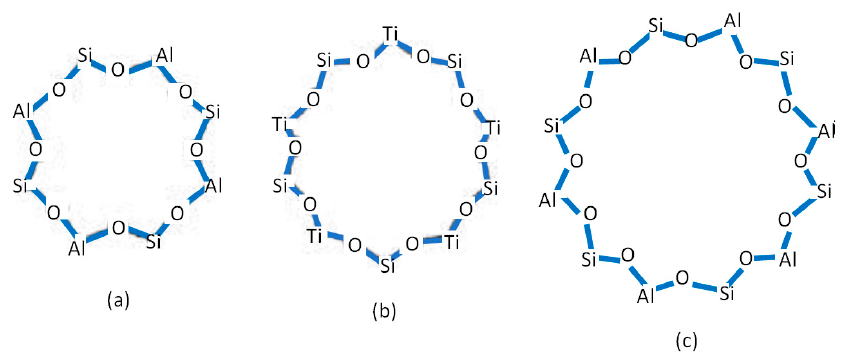
Figure 1. The pore geometry of ( a ) zeolite LTA, ( b ) zeolite TS-1, and ( c ) zeolite Y. Zeolite X has the ability to attract other molecules that touch the surface of the zeolite [21]. Zeolite X has a large Si/Al ratio, so it has thermal and chemical stability [22]. Zeolite X is a type of zeolite that has an α -cage (supercage) diameter of 13 Å, a β -cage (sodalite frame) diameter of 6.6 Å, and a pore diameter of 7.4 Å that form a three-dimensional struc- ture with an Si/Al ratio of 1.0–1.5 [23]. Zeolite X has a unique crystalline structure, large adsorption capacity, and selective adsorption. Therefore, zeolite X has been widely used as an adsorbent. In this study, the development of an imprinted-zeolite-X-based sensor was carried out as a sensor for the detection of glucose in the blood. Zeolite X was synthe- sized with a ratio of molar composition of Na 2 O, Al 2 O 3 , TEOS, and H 2 O of 4.5:1:3:315, using the sol–gel-hydrothermal method at 100 °C [24] . The parameter that was studied was the composition of the electrode. This study also reports the mechanism of adjusting the pore size of the imprinted zeolite according to the result of the nitrogen physisorption isotherm. This provides a more in-depth explanation of the performance of the IZ as a potentiometric sensor. 2. Materials and Methods 2.1. Materials The chemicals used in this study were glucose (Sigma Aldrich, St. Louis, MO, USA, 99.5%) and uric acid (Fluka, Buchs, Switzerland, 99%), tetraethyl orthosilicate (Merck, Rahway, NJ, USA, 99%), sodium aluminate (Sigma Aldrich, 50%), sodium chloride (Merck, 99.99%), potassium chloride (Merck, 99.5%), isopropanol (Merck, 98%), and par- affin pellet (Merck, 99%). Potassium chloride, urea, sodium chloride, and glucose solu- tions were prepared using distilled water. The 10 − 2 M uric acid solution was prepared by dissolving the uric acid powder in 1:1 NaOH ( w / w ). Acetate buffer was prepared by mix- ing sodium acetate trihydrate (Merck, 99.5%) and the glacial acetic acid (Merck 100%). Phosphate buffers were prepared by mixing sodium hydrogen phosphate dihydrate (Merck, 99%) and sodium dihydrogen phosphate dihydrate (Merck, 98.5%) in distilled water. The chemical activation of carbon powder was achieved by immersing it in n-hex- ane and 0.1 M H 3 PO 4 , respectively. Furthermore, the carbon powder was heated to 300 °C for 2 h [5] and produced activated carbon with a surface area of 587.5106 m 2 /g. The carbon paste and potentiometer were connected via a Ag wire. The following instruments were used in this study: Cyberscan 510 potentiometers with Ag/AgCl as a reference electrode, the Gas Sorption Quantachrome ASIQwin, X-ray diffraction (Shimadzu, Kyoto, Japan), a Fourier transform infrared (FTIR) spectrophotom- eter (Shimadzu), a double-beam spectrophotometer (Shimadzu UV-1800 Pharmaspec), an analytical balance (Mettler AE 200, Columbus, OH, USA), a centrifuge (HETTICH EBA 20, Westphalia, Germany), a hotplate (Termolyne S46410-2, Rockland, MA, USA), a vac- uum oven (NAPCO Model 5851, Amityville, NY, USA), a pH meter (Cyberscan Eutech pH 510, Frankfurt, Germany), a polypropylene bottle, a 1000 μ L micropipette tip (Nes- coLab, Jakarta, Indonesia), a magnetic stirrer (Heidolph, Schwabach, Germany), an agate